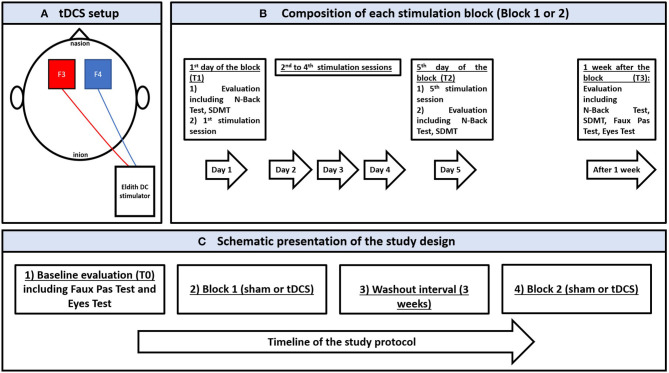
(A) schematic presentation of the transcranial direct stimulation setup showing the anode (in red) and the cathode (in blue) over F3 and F4, respectively, according to the 10–20 international electroencephalographic system for electrode positioning; the electrodes are connected to a battery-driver direct current stimulator. (B) schematic presentation of a stimulation block (sham or active) showing the stimulation and evaluation sessions between the 1st day of stimulation and 1 week after the last stimulation. (C) schematic presentation of the study protocol showing the chronological order of experimentation. SDMT: Symbol Digit Modalities Test.